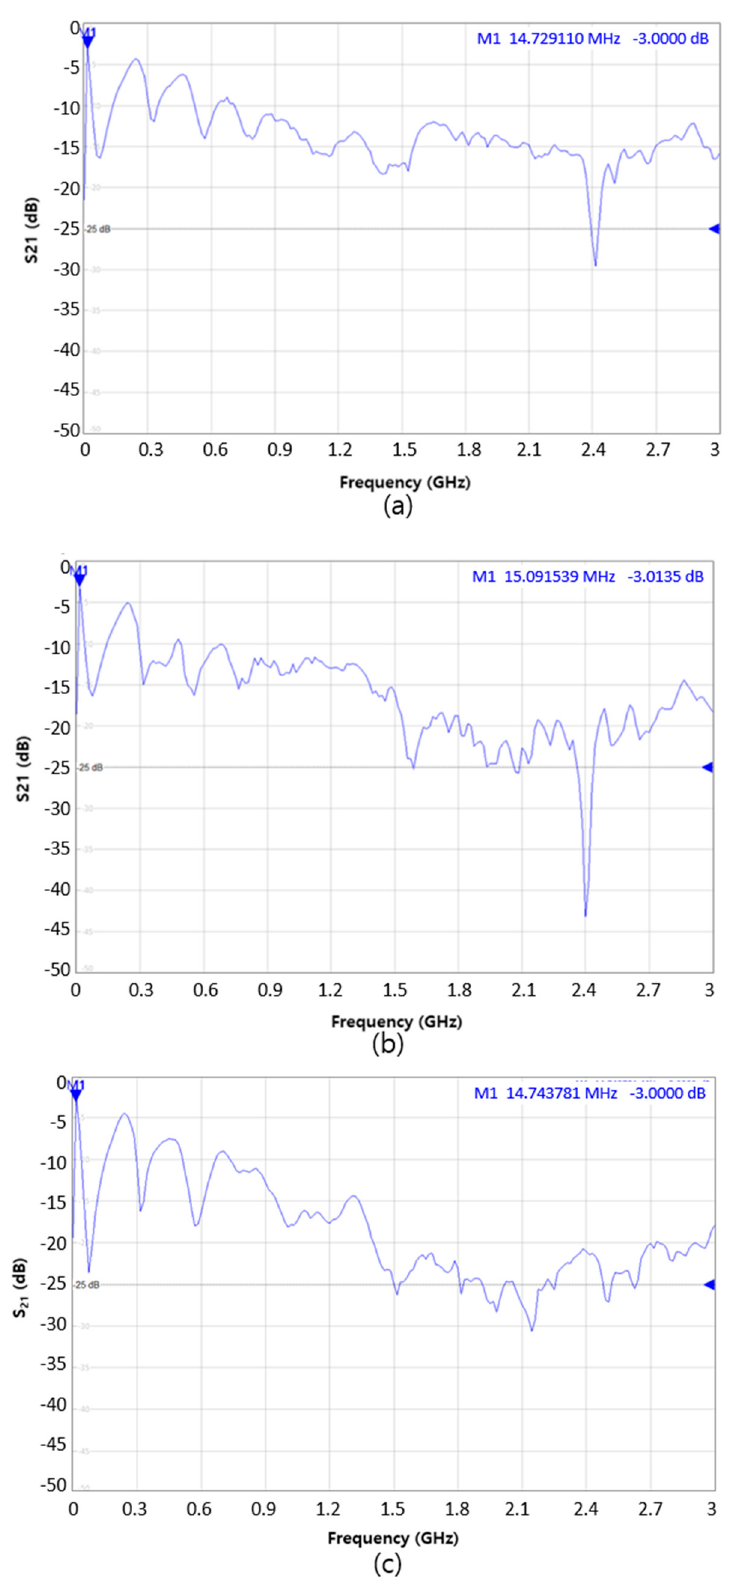
Figure 6. S21 characteristic curves of the sample: ( a ) PD2-D, ( b ) PD3-D, ( c ) PD4-D.